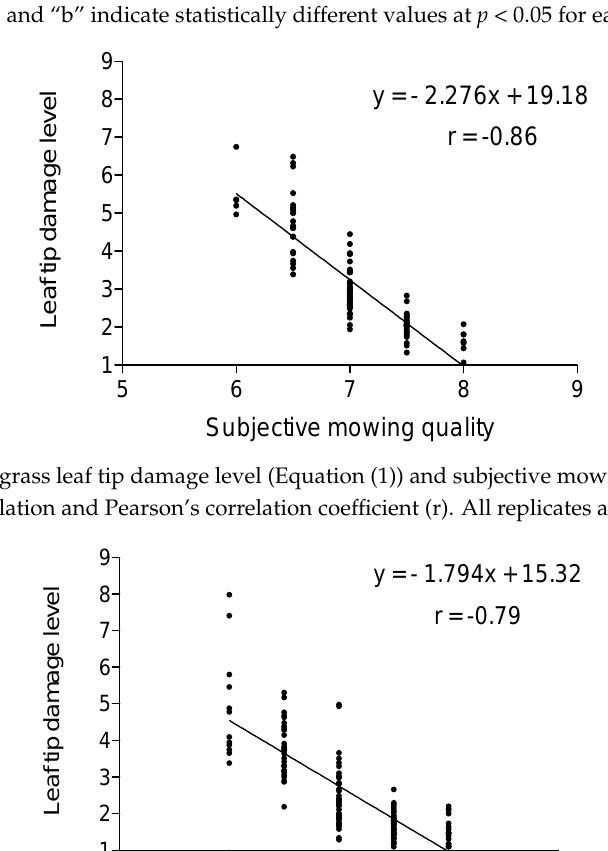
Figure 8. Tall fescue leaf tip damage level (Equation (1)) and subjective mowing quality (1 = poor, 9 = excellent) correlation and Pearson’s correlation coefficient (r). All replicates are reported.